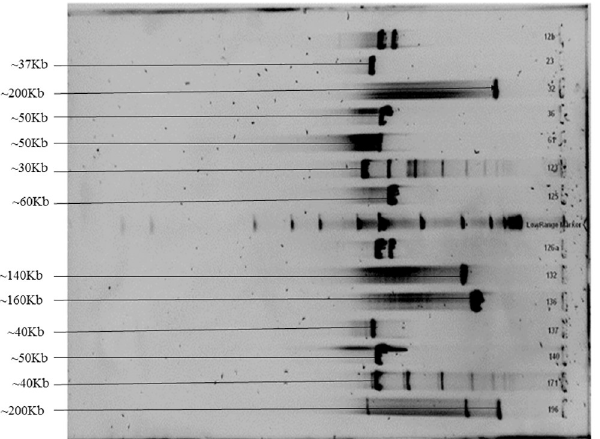
Fig 4. Pulsed-field gel of the 13 phage genomes. Lane, (1) vB_EauM-23, (2) vB_VmeM-32, (3) vB_BpsS-36, (4) vB_BpsM-61, (5) vB_EauS-123, (6) vB_BboS-125, (7) vB_BhoP-126, (8) vB_EalM-132, (9) vB_BcoS-136, (10) vB_EalM-137, (11) vB_BpsS-140, (12) vB_BhaS-171, (13) vB_VmeM-196, (M) Low range PFGE DNA marker in Kb (Biolabs,